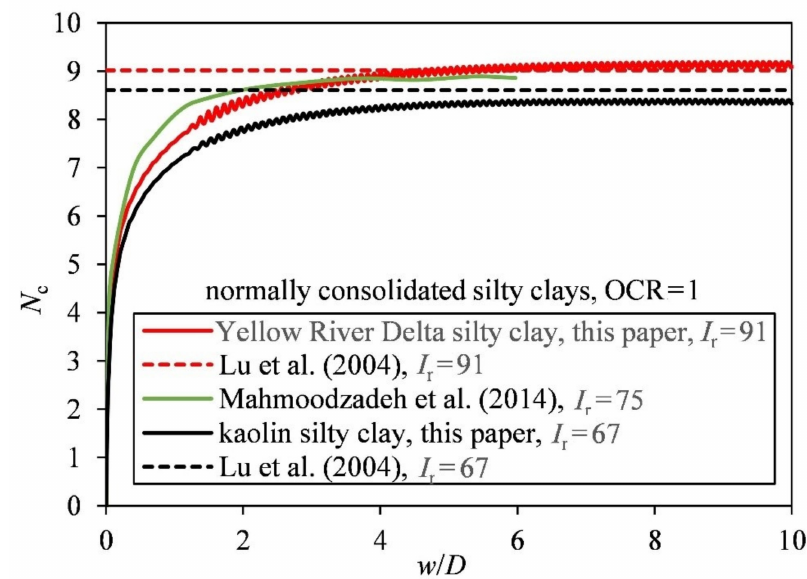
Figure 2. Comparison of calculation results [6].